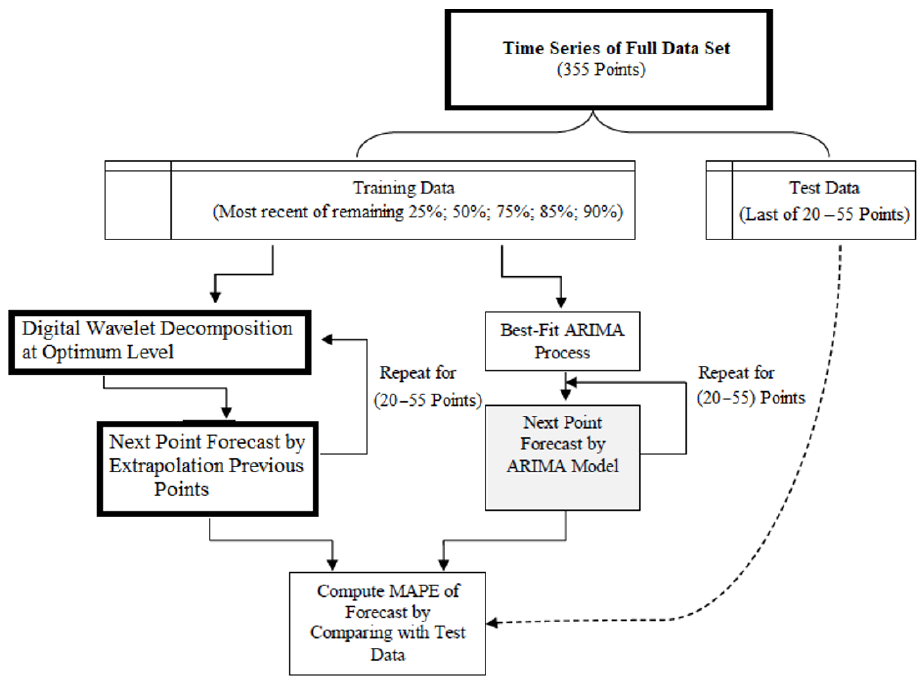
Figure 1. Simulation process flow chart (MAPE—mean absolute percentage error). Source: authors’ compilation.